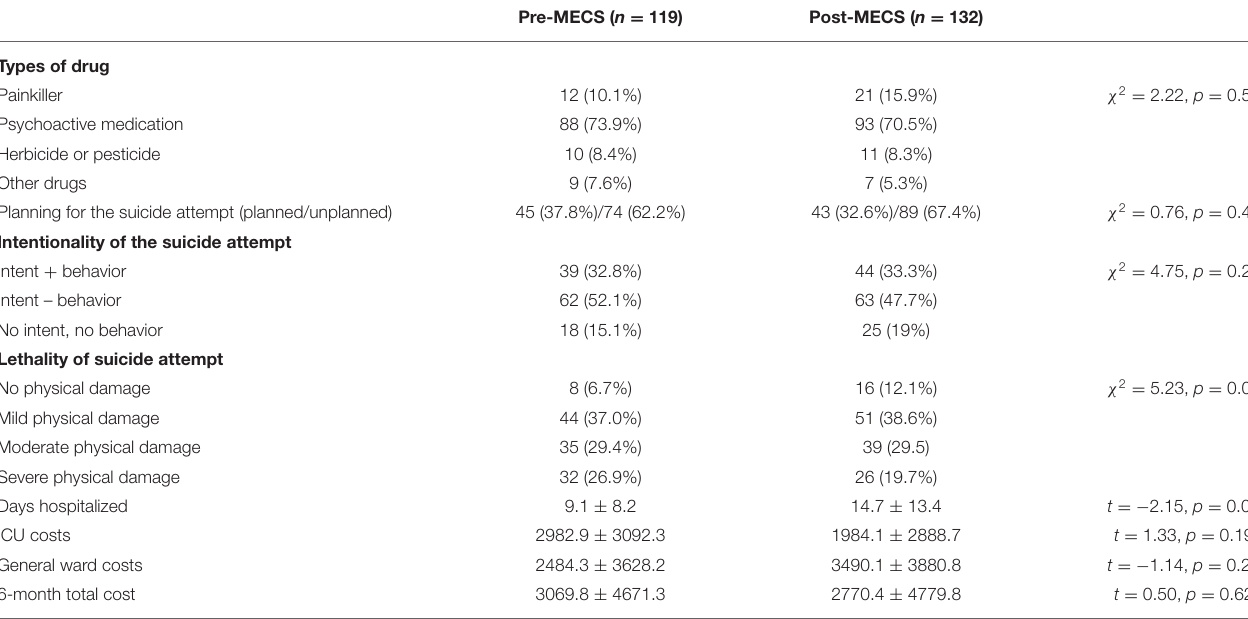
TABLE 2 | Comparison of suicidal patterns and hospital costs in all patients.